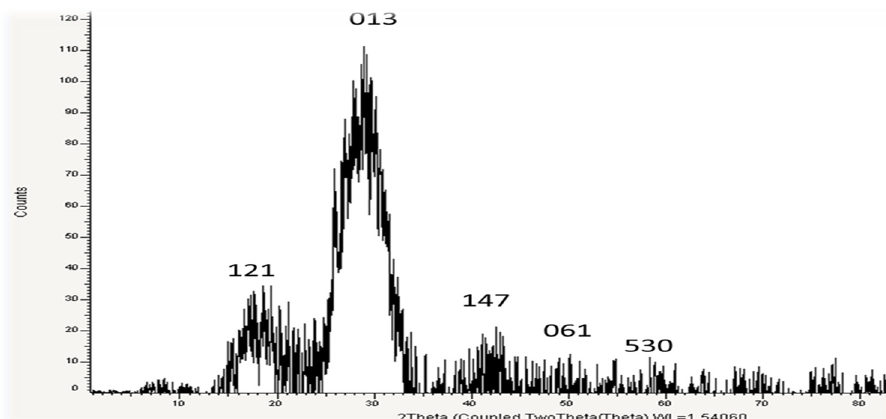
Figure 4. XRD spectrum of